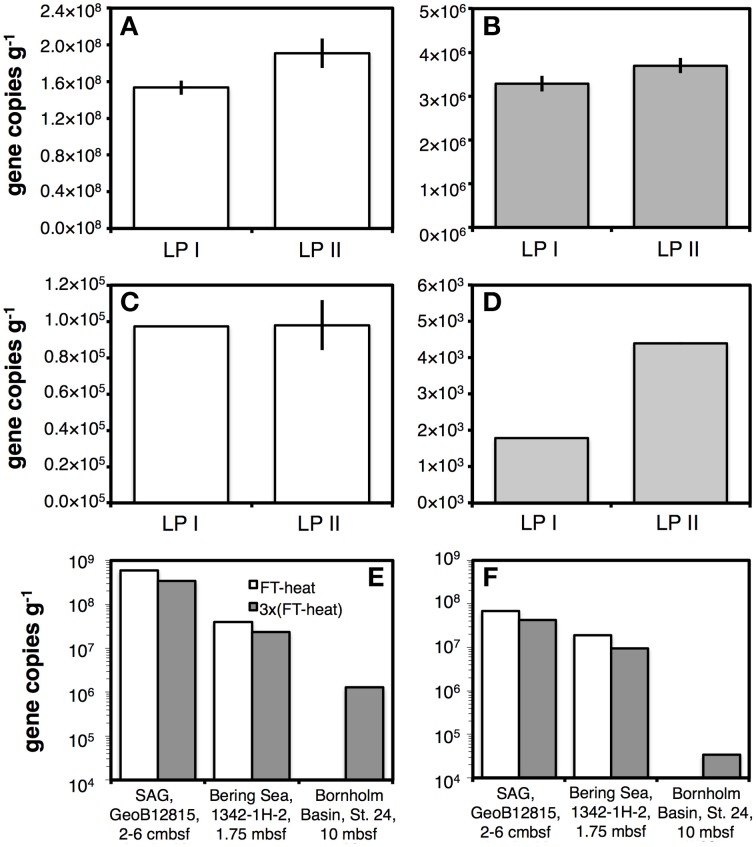
Results of qPCR assays on bacterial 16S rRNA gene copy numbers are shown in the left column, results for Archaea in the right column. (A,B) Gene copy numbers in sediment from an oligotrophic glacial lake in Greenland obtained using a rapid lysis method involving PCI addition during bead-beating and no freeze-thaw+heat cycles (LP I) compared to a slower lysis method involving bead-beating without PCI followed by one freeze-thaw+heat cycle (LP II). (C,D) Same treatments as in (A,B), tested on sediment from highly oligotrophic Subglacial Lake Whillans. (E,F) Effects of increasing the number of freeze-thaw+heat (FT-Heat) cycles from one to three on oligotrophic sediments from three locations. Error bars indicate data ranges for samples where extractions were duplicated (A–D).